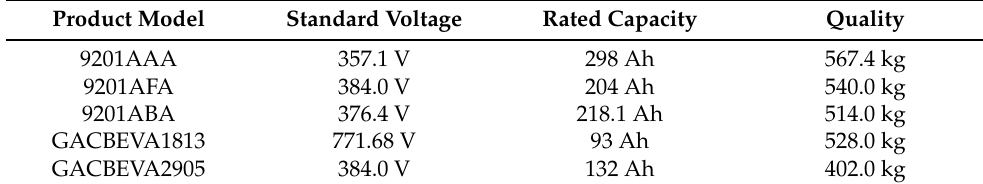
Table 3. The information of